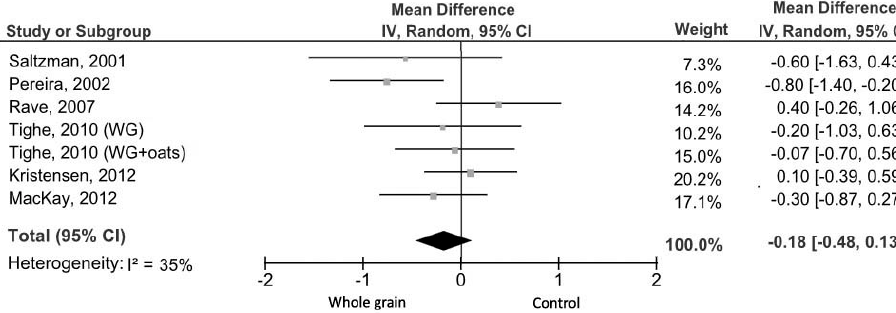
Figure 6. Forest plot of the meta-analysis carried out to investigate the effect of whole grain consumption on HOMA-IR. WG, whole grain.